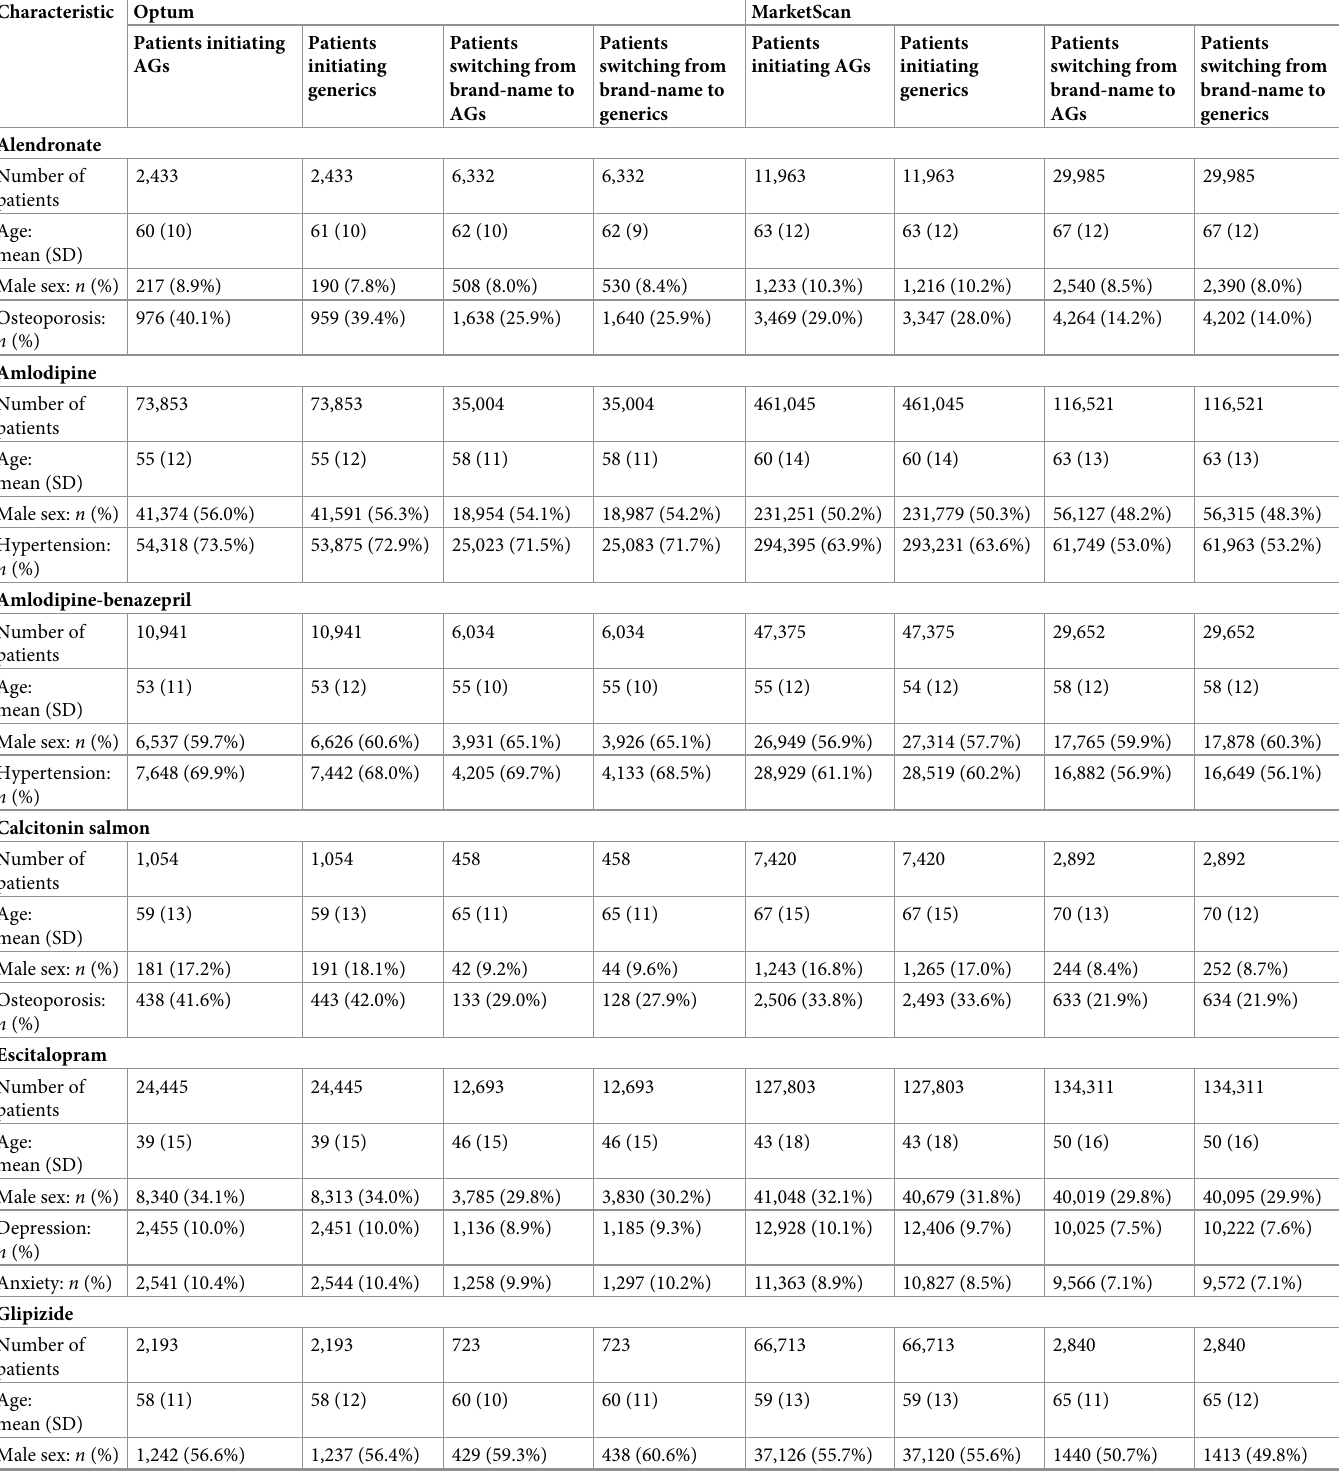
Table 1. Characteristics of patients included in the evaluation of comparative outcomes for patients initiating authorized generics (AGs) versus generics and patients switching from brand-name to AGs versus generics after 1:1 propensity score matching in each database. Characteristic